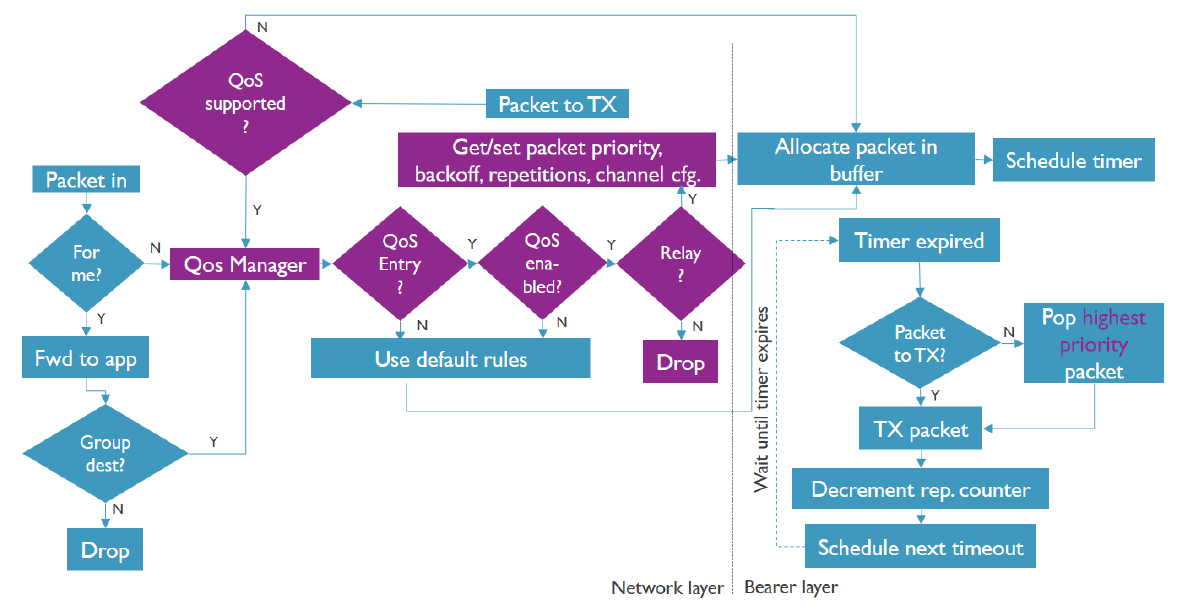
Figure 10. Flowchart for QoS enabled packet